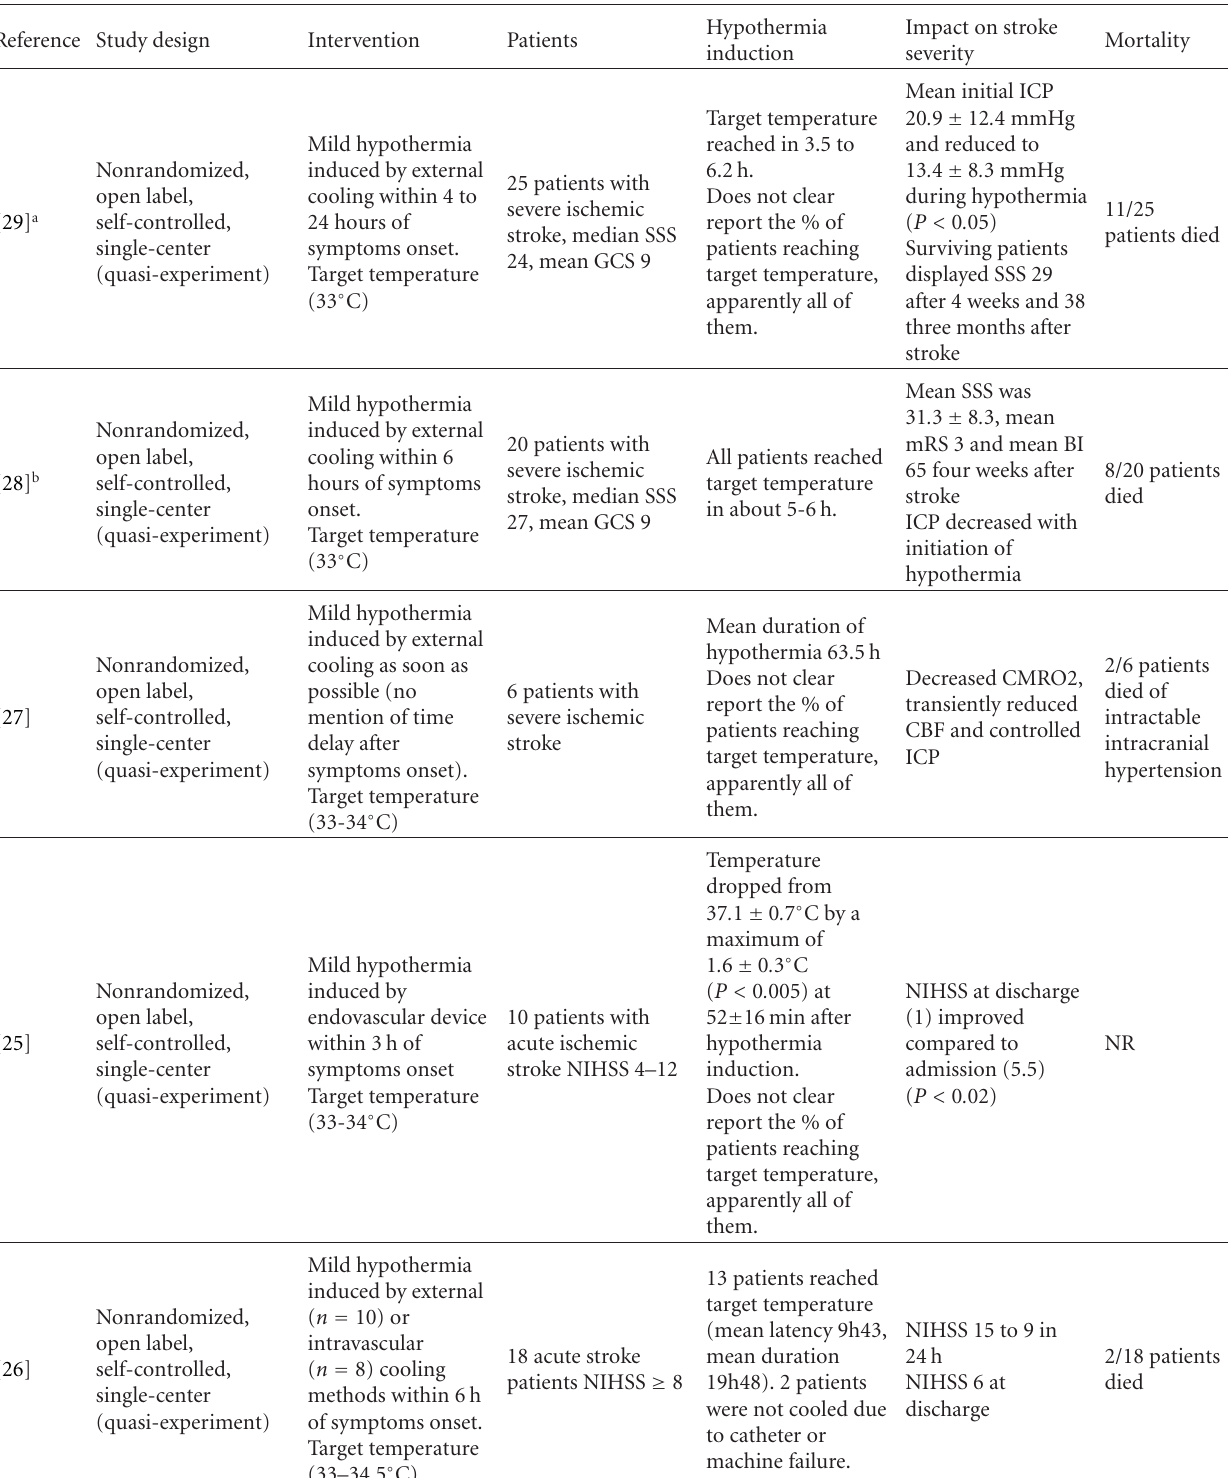
Table 2: Self-controlled clinical trials (quasi experiment) of feasibility and e ffi cacy of hypothermic intervention for stroke. Reference Study